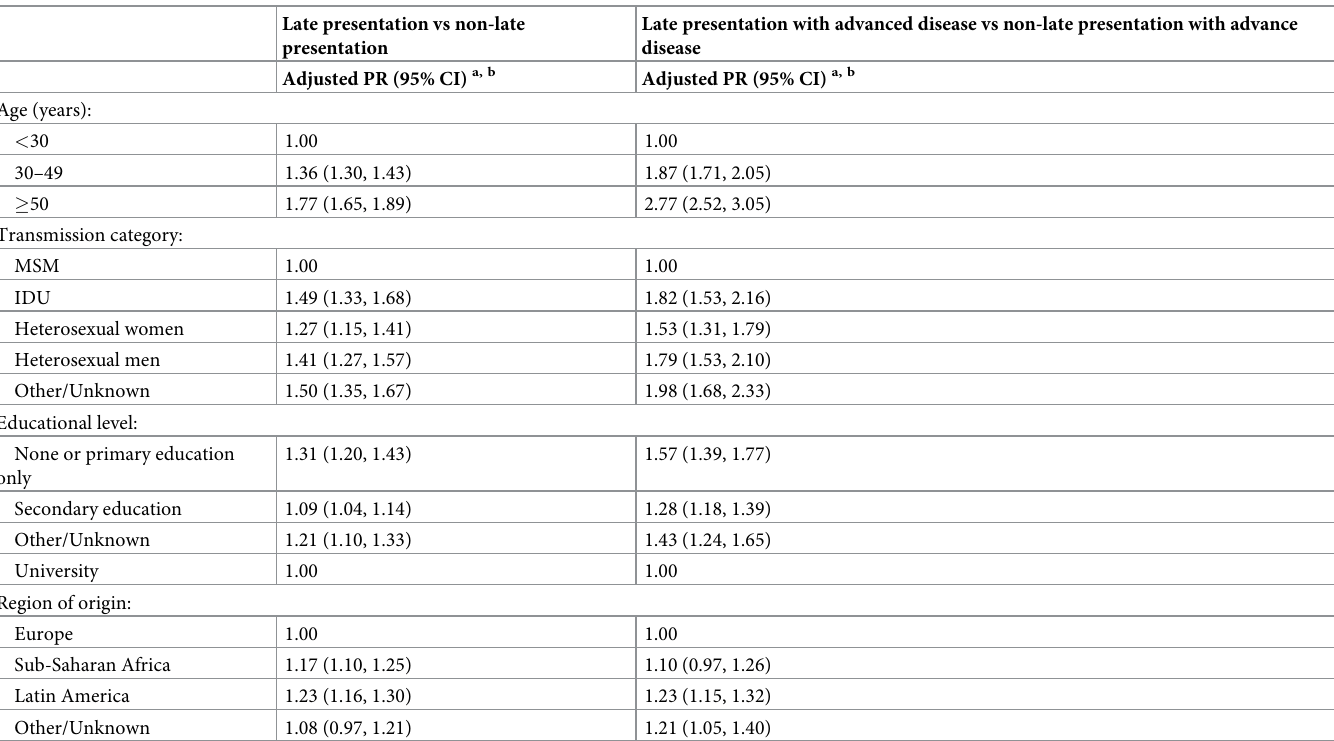
Table 2. Independent risk factors associated with late presentation and late presentation with advanced disease, Spain, 2004–2018 (N =